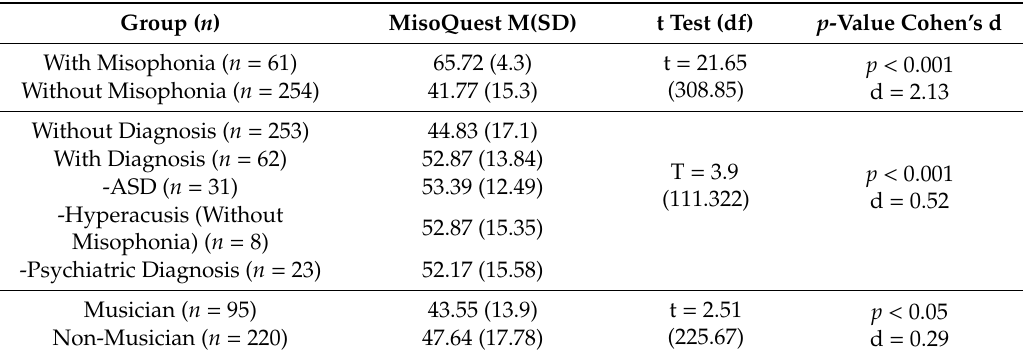
Table 3. Criterion-related validity of